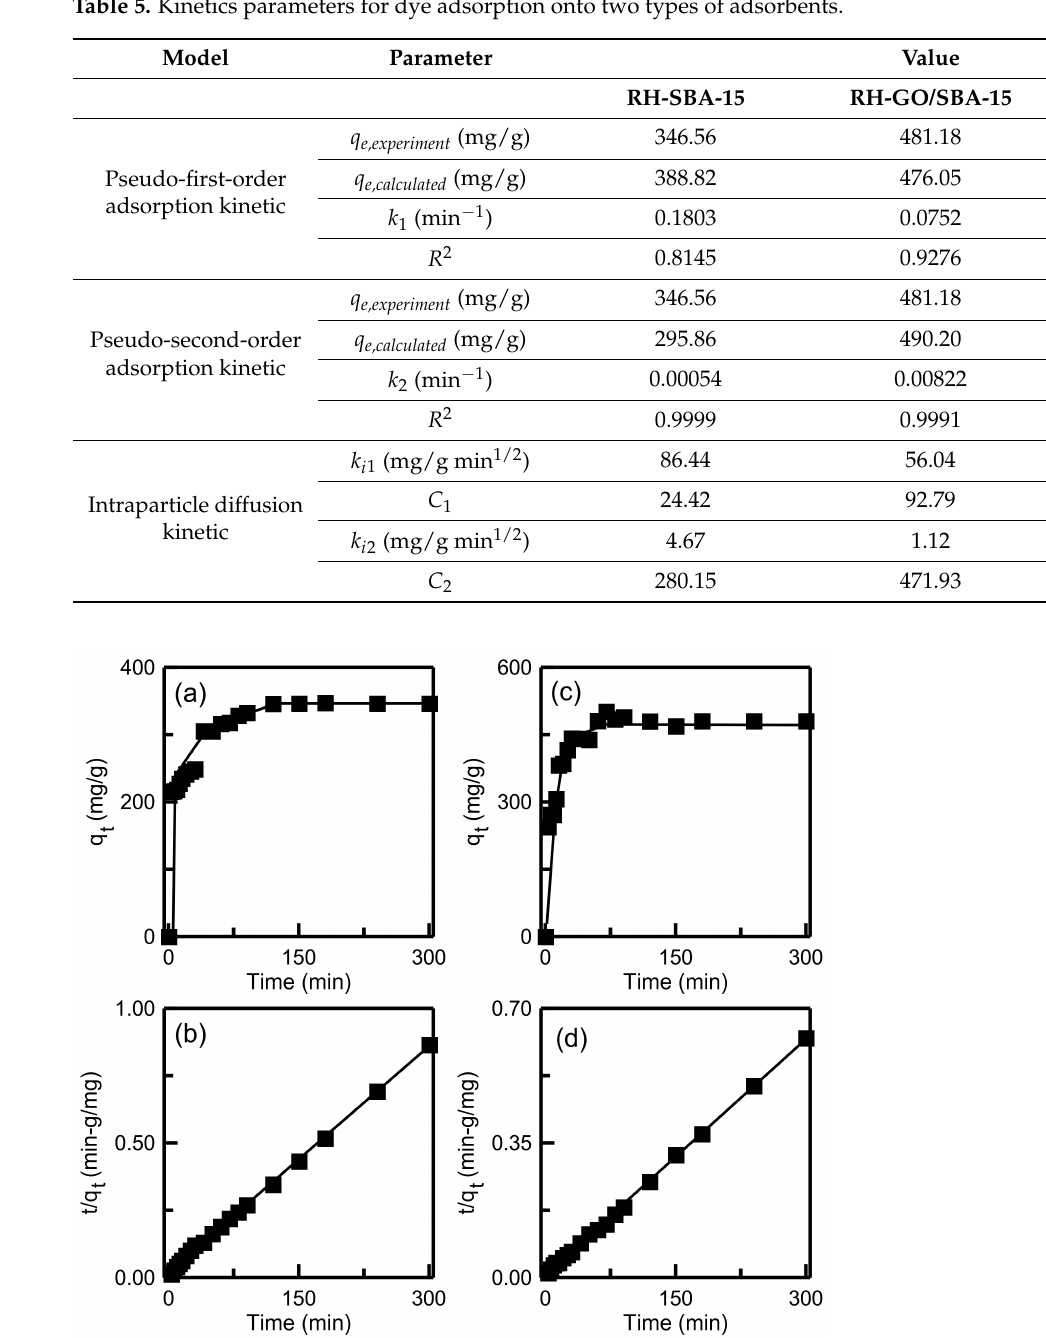
Figure 14. Adsorption kinetics of dye onto adsorbents: pseudo-first order model for ( a ) RH-SBA-15 and ( c ) RH-GO/SBA-15; pseudo-second order model for ( b ) RH-SBA-15 and ( d )